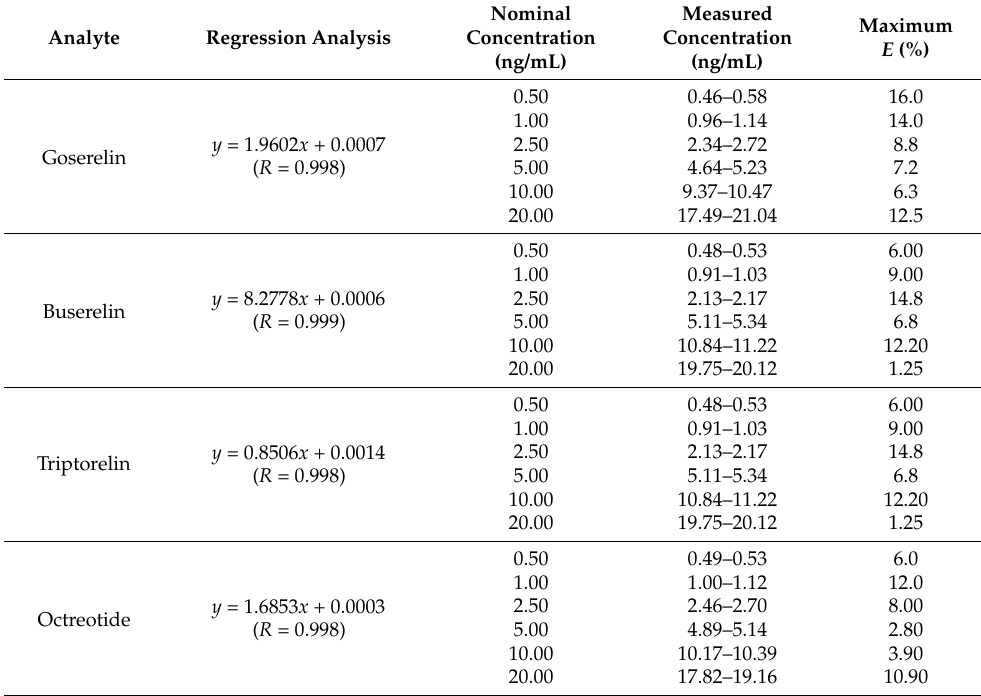
Table 1. Summary of linearity data for goserelin, buserelin, triptorelin, and octreotide over the concentration range of 0.5–20.0 ng/mL.